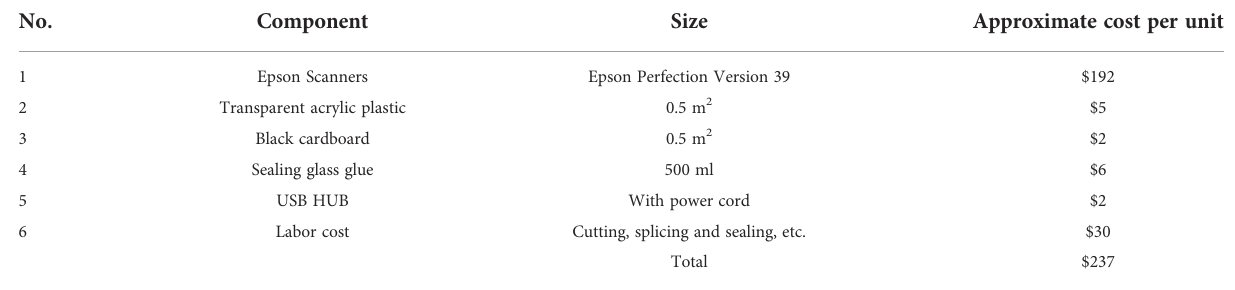
TABLE 1 Details and costs of individual components in the RhizoPot